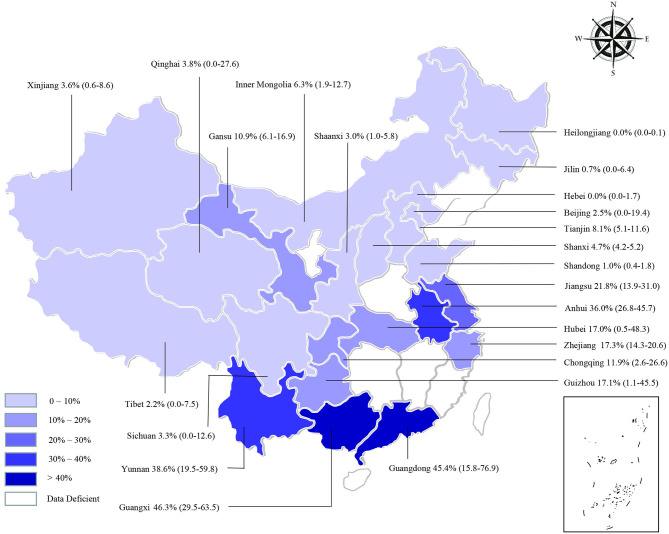
Bluetongue virus infection in cattle in China. Different saturations in the HSB slider represent different infection rates.